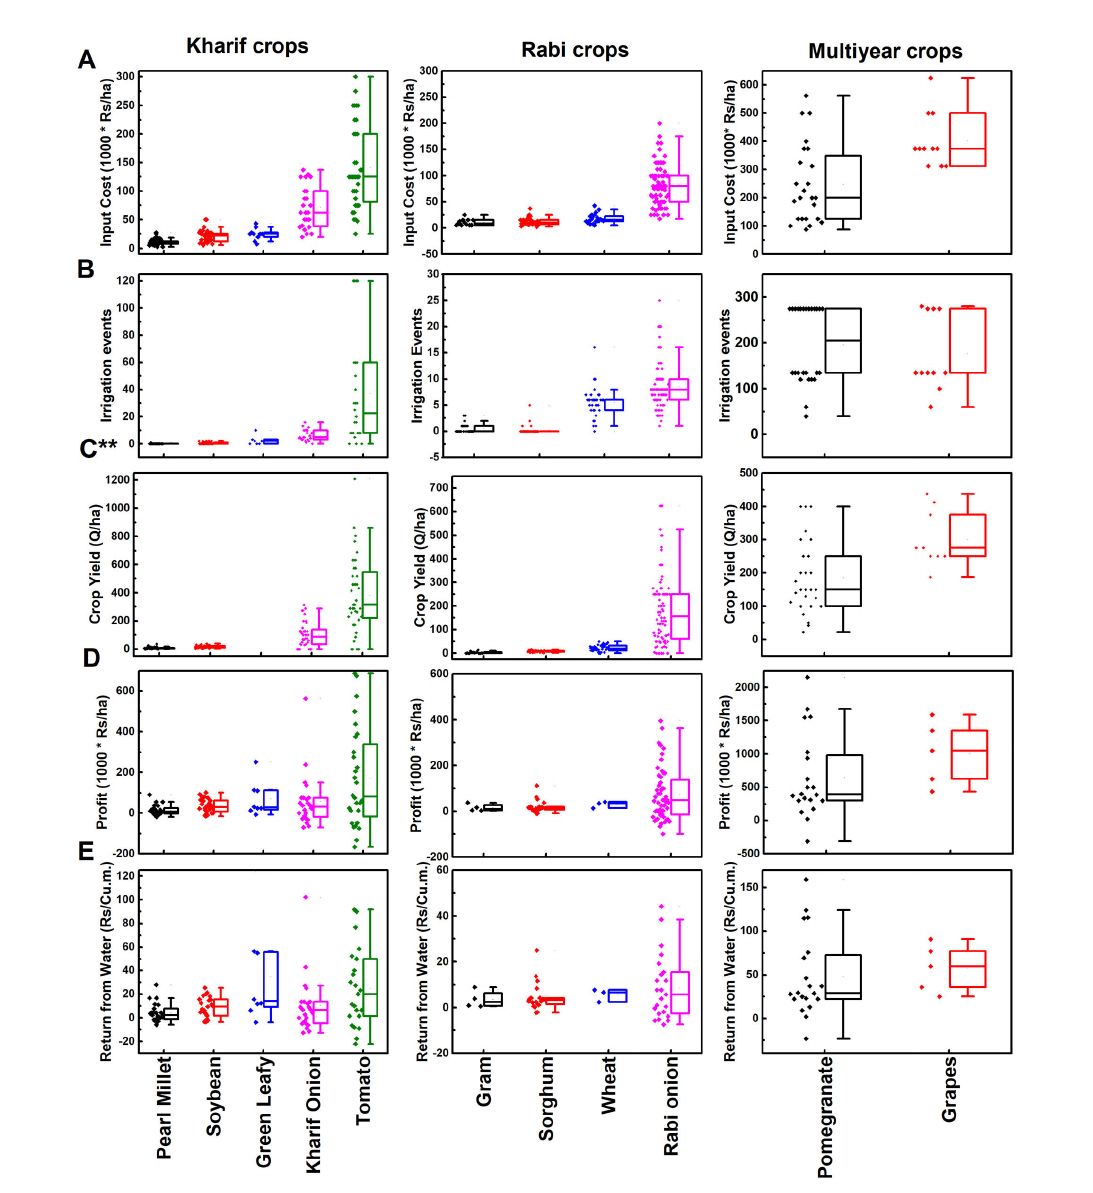
Fig. 4 . Seasonal crop intensification hierarchy and farm economics. Key economic attributes of main Kharif (monsoon), Rabi (winter), and summer crops. (A) Input cost; (B) Irrigation events: number of times that the crop was irrigated during the crop duration for seasonal crops or through a year for multiyear crops. All crops except fruit orchards and a share of tomato crops are irrigated using flood irrigation. (C) Crop yield in quintal/hectare; (D) Profit per hectare (E) Return from water (in Rupees per cubic meter of water required by crop). As farmers shift their cropping pattern along the hierarchy toward horticulture crops, they face significantly higher input costs and need for irrigation. Farmers vary in their ability to fully irrigate their crop, which contributes to high variation in crop yields and hence, farm returns. Though average returns increase as farmers intensify along the crop hierarchy, it can be seen that a significant share of horticulture farmers faces crop failure. The high return per unit water for horticulture crops explains large investment in water infrastructure. Volume of data-points for different crops varies because it depends upon number of farmers who cultivated each crop in the survey year. Data is for year 2015-2016 based on surveys of sampled farmers. Survey data for 2016-2017 was not used for this analysis because an extraordinary external event of national currency demonetization in Nov 2016 resulted in severe market distortion. **Yield for green-leafy vegetables unavailable because they are not sold by weight but in nonstandard sized